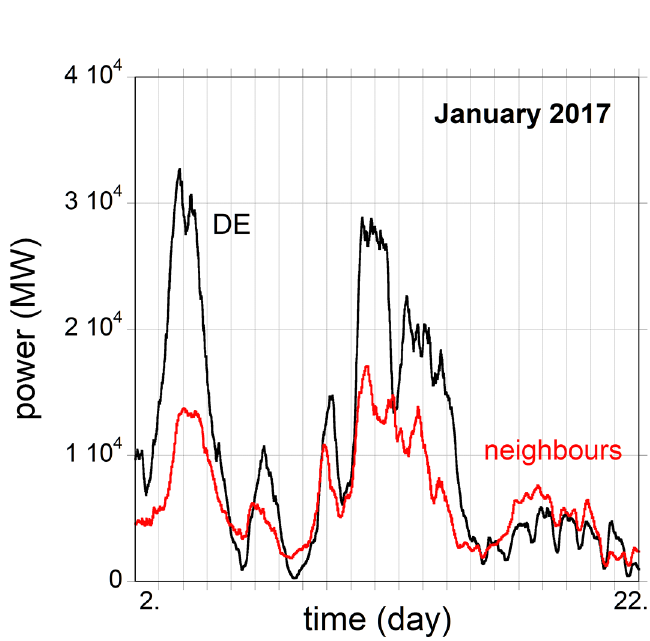
Fig. 11. – This figure compares the onshore wind power for Germany with the one of some of its neighbours (DK, PL, CZ, FR, BE, NL) for the period January 2nd to 22nd, 2017. Data from ENTSO-E and the German grid